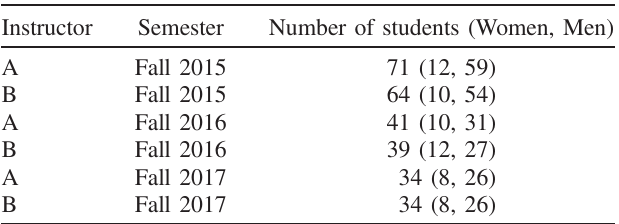
TABLE I. Demographics of the student population in the physics majors ’ introductory physics courses ( N ¼ 283 , 60 women, 223